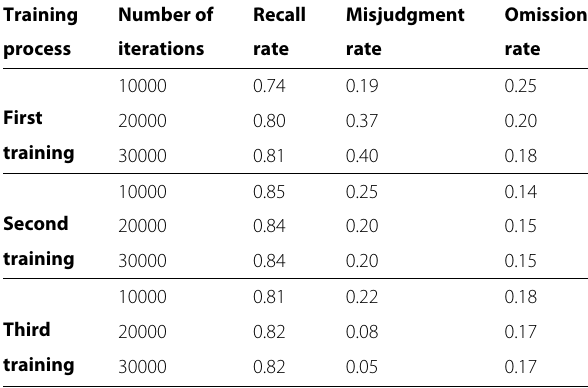
Table 4 Evaluation of the system